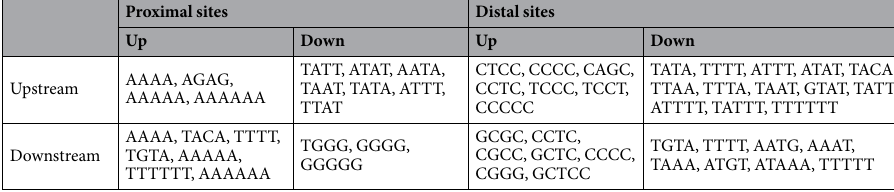
Table 2. Summary of cis-regulatory elements around the upstream and downstream of poly(A) sites in APA switching